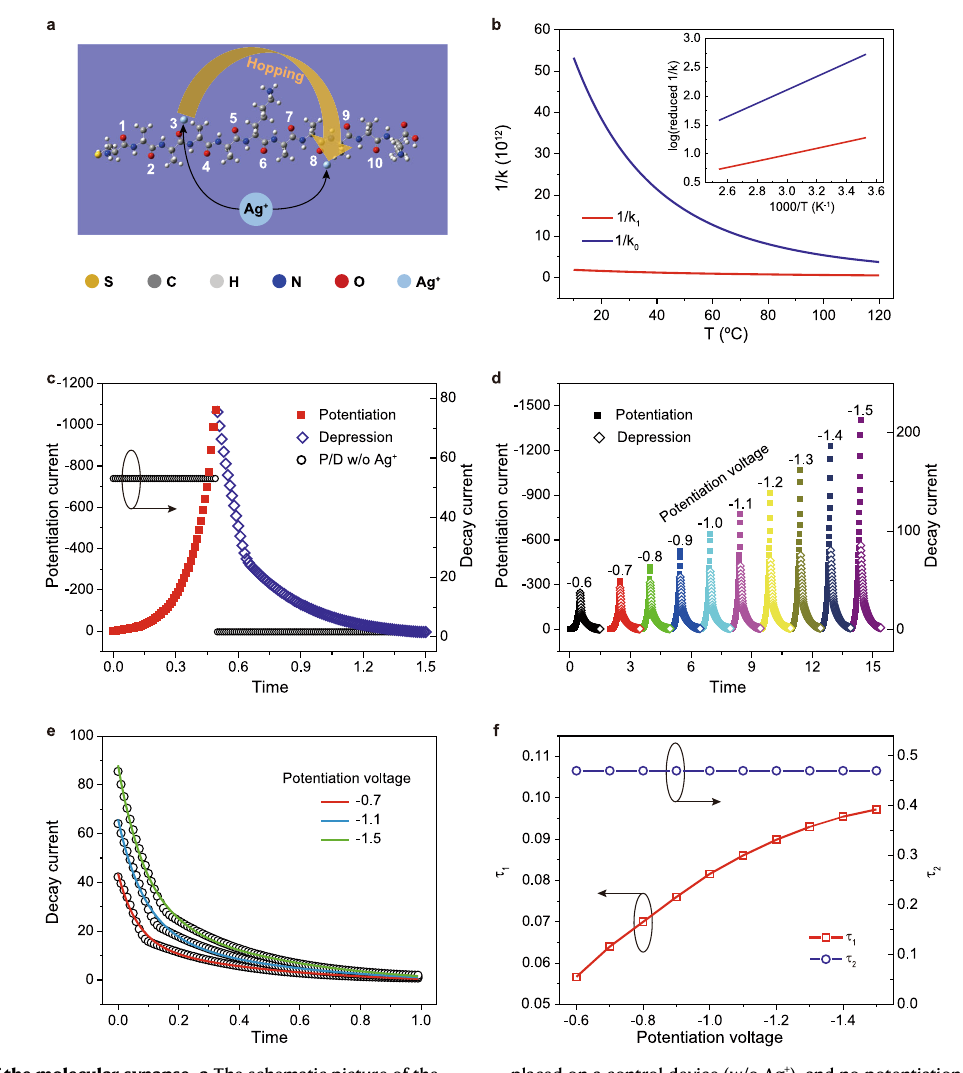
placed on a control device (w/o Ag + ), and no potentiation/depression character- isticisfound( black circle, righty -axis). d Simulatedpotentiation( solid squares, left y -axis) and depression ( hollow diamonds, right y -axis) of Ag/AgO x //CAAAAKAAAA //GaO x /EGaIn synapse under voltages from − 0.6 to − 1.5V. e Simulated current decay curves after potentiated by − 0.7, − 1.1, and − 1.5V ( hollow circles). The fi tted solid lines are obtained by using a double exponential function (cid:3) (cid:4) (cid:3) (cid:4) + b *exp (cid:2) t = τ 2 + c . f Dependence of the fi tting time constants τ 1 I = a *exp (cid:2) t = τ 1 and τ 2 on the potentiation